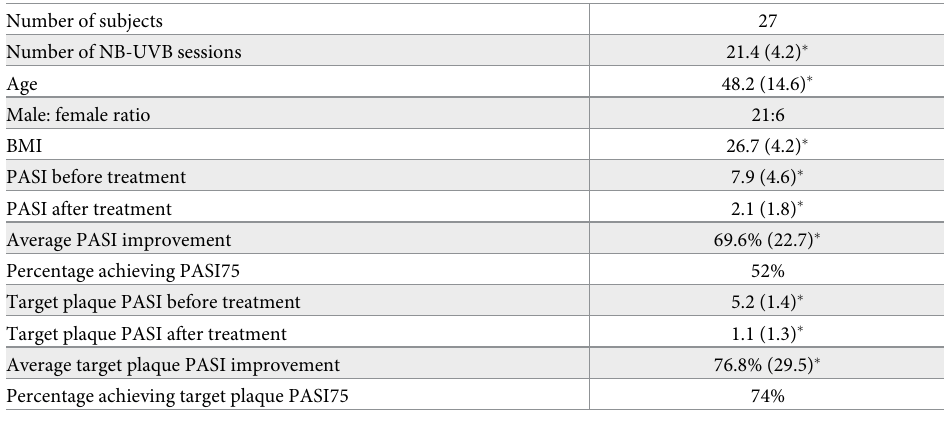
Table 1. Patients’ demographic data and NB-UVB treatment